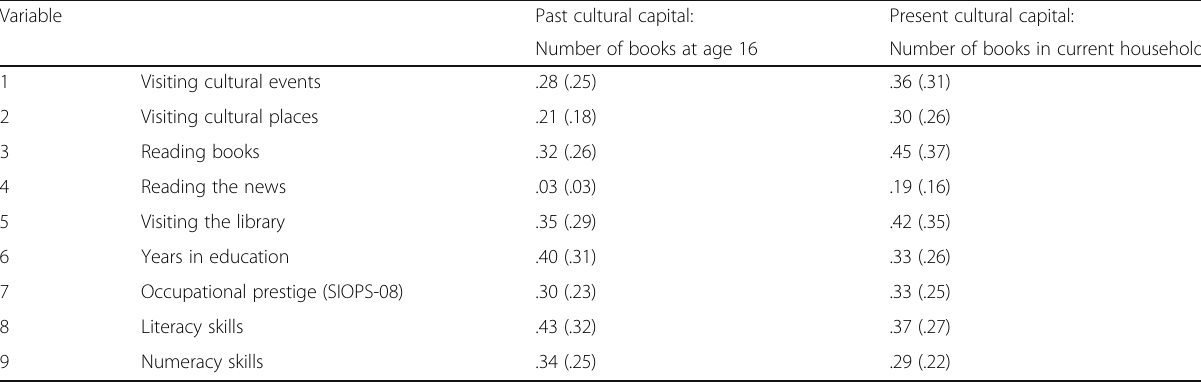
Table 5 Convergent and divergent validity of the past and present cultural capital measures in PIAAC-L 2015